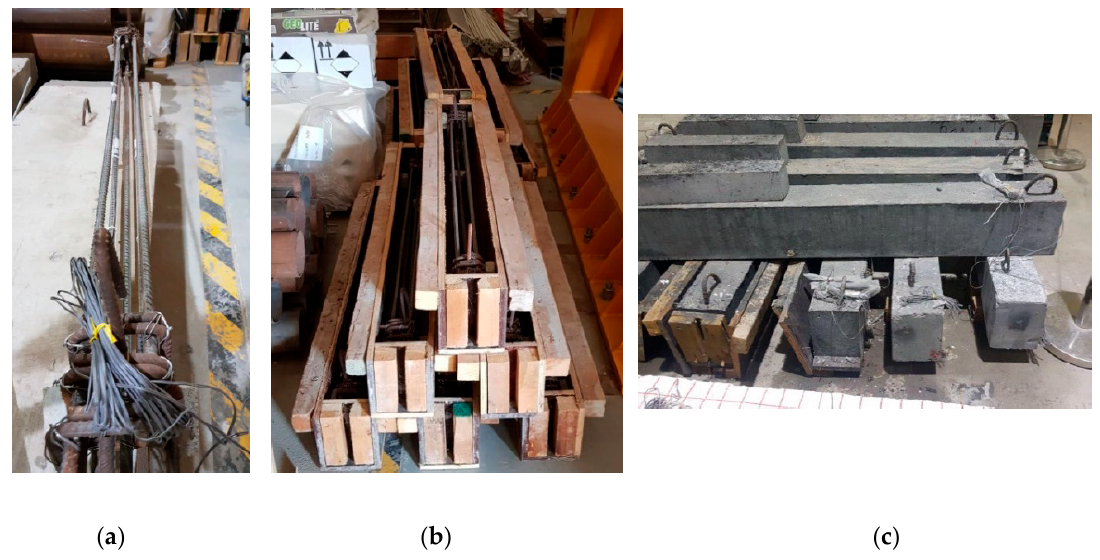
Figure 7. Samples during preparation. (a) Steel reinforcement with strain gauges, (b) Formwork before casting, (c) Samples after curing.